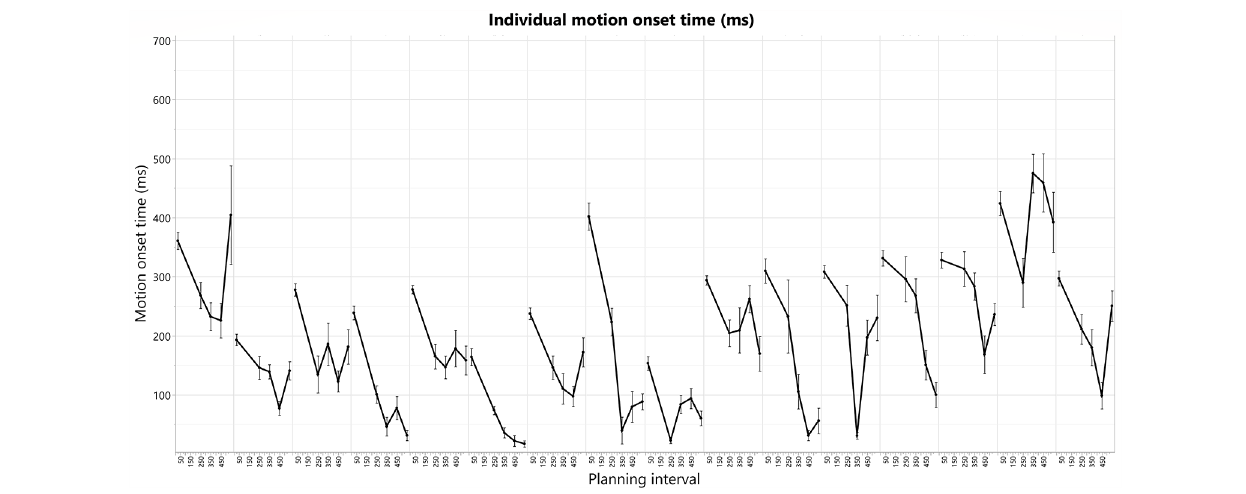
FIGURE 5 | Individual motion-onset RT for each subject and each planning interval condition, averaged over four targets, and all trials for each target.